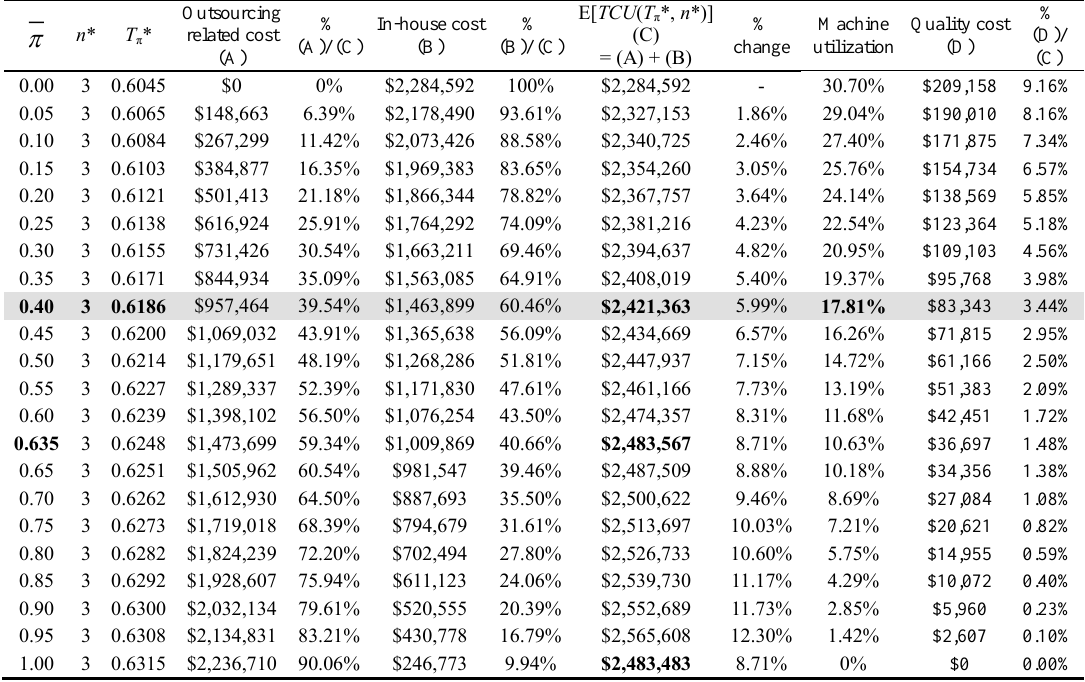
Table 2. Effects of changes in the average outsourcing factor on various system